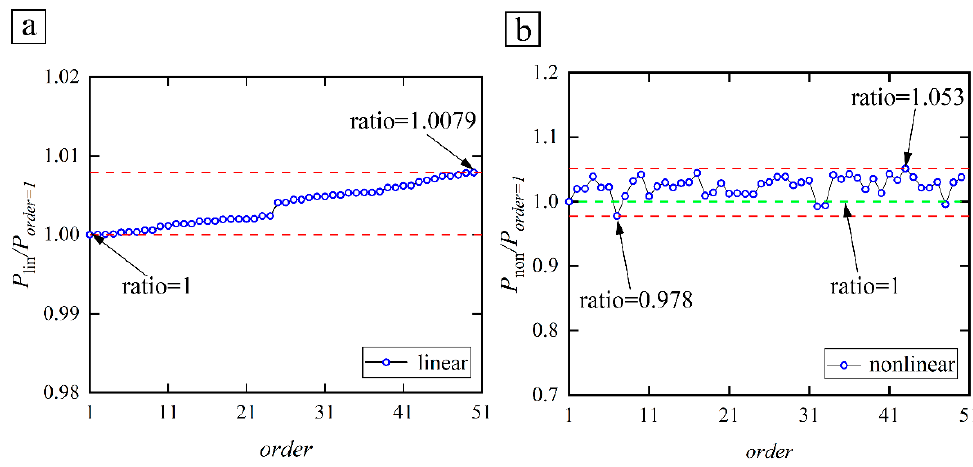
Figure 11. Normalized linear and nonlinear buckling loads for sphere-segmented toroidal shells.